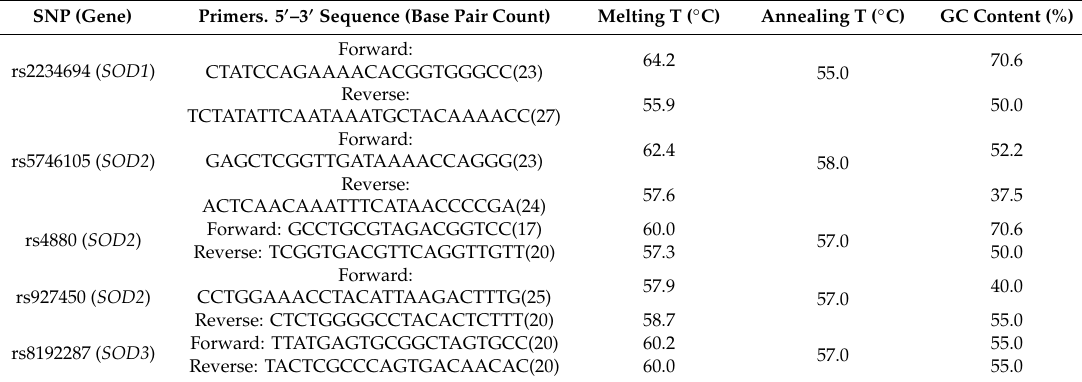
Table 14. The characteristics of primers used for genotyping (method: PCR-RFLP).